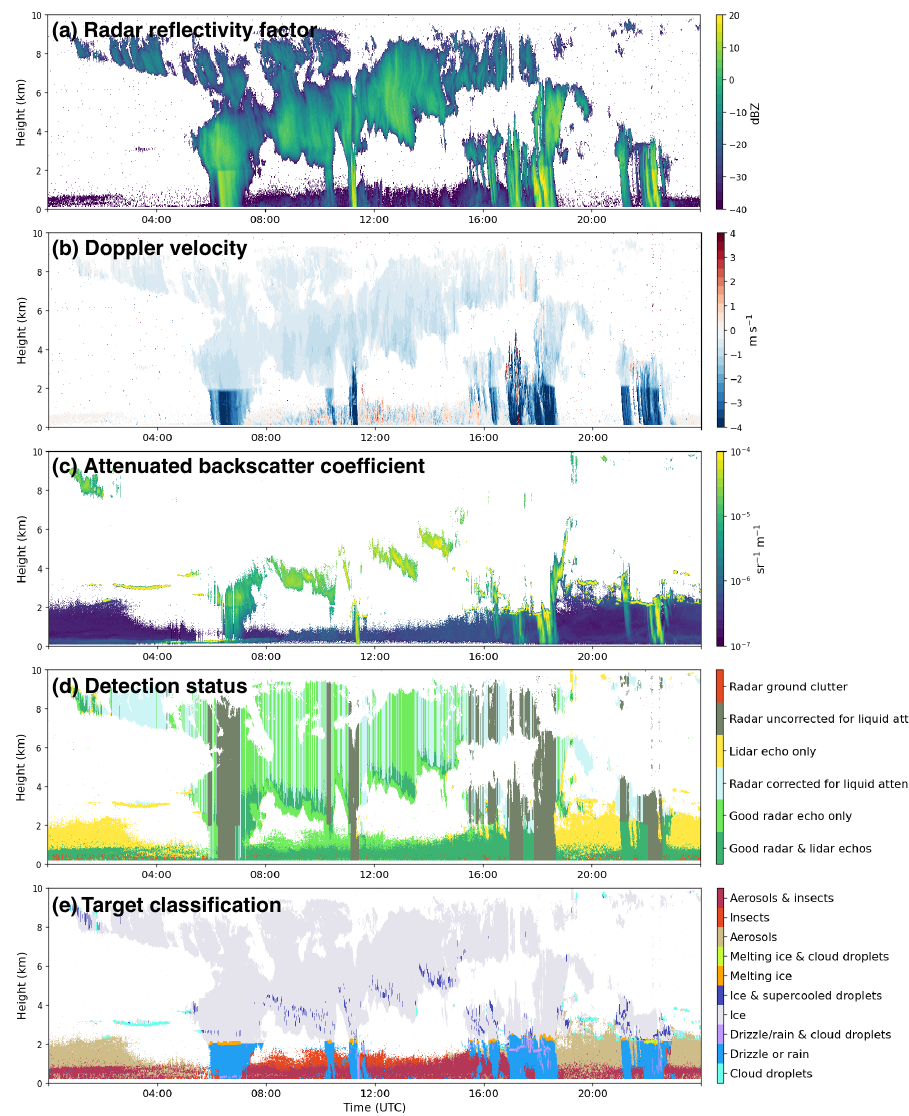
Figure 4. Time series of ( a ) radar reflectivity factor (dBZ), ( b ) Doppler velocity (m s − 1 ), ( c ) attenuated backscatter coefficient (sr − 1 m − 1 ), ( d ) detection status, and ( e ) target classification based on the Cloudnet algorithm for 29 May 2020 between 0000 UTC and 2359 UTC. (Source https://cloudnet.fmi.fi, [39], accessed on 6 December